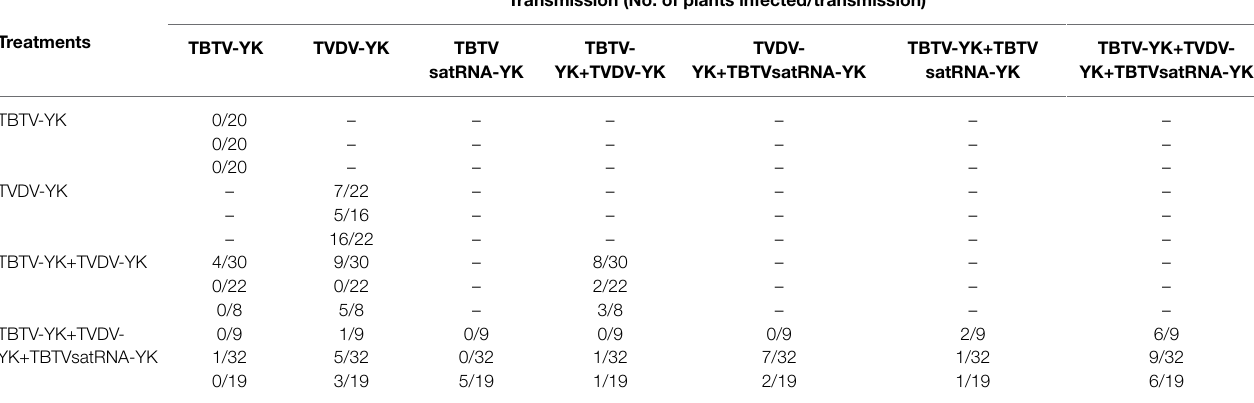
TABLE 2 | Transmission efficiencies of TBTV-YK, TVDV-YK, and TBTVsatRNA-YK of TBTD by Myzus persicae .